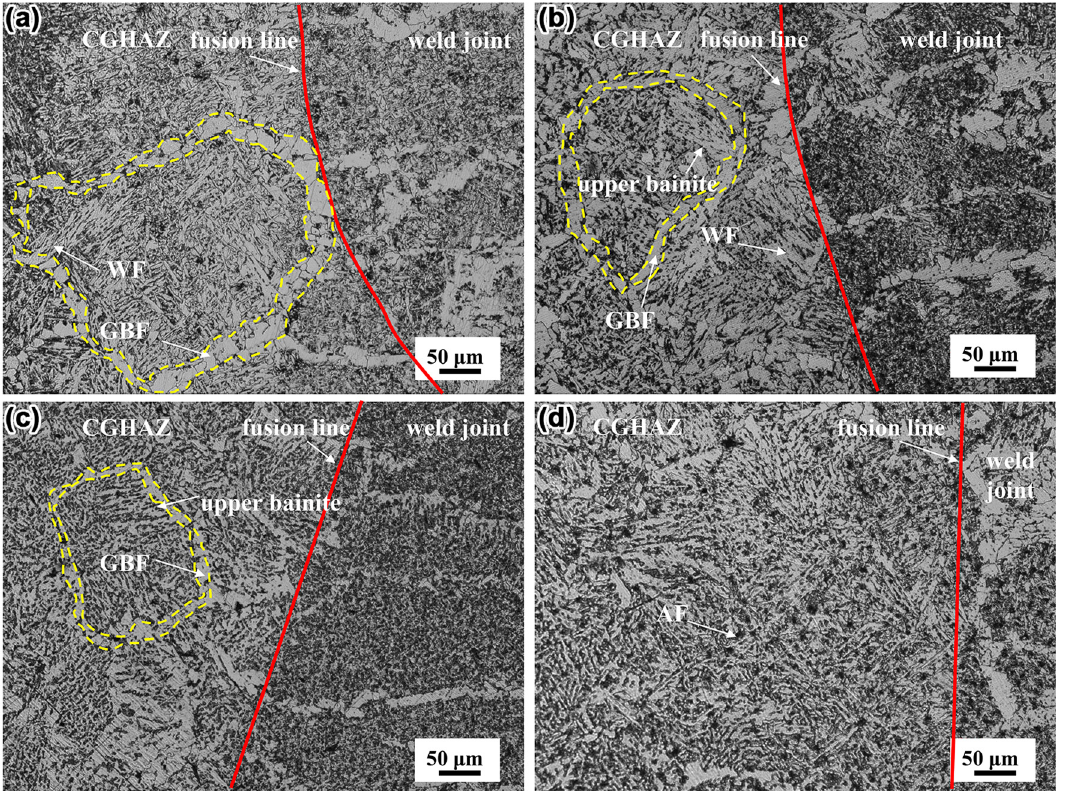
Figure 6. The microstructure of coarse-grained heat-affected zone (CGHAZ) in steels, ( a ) N1 steel, ( b ) N2 steel, ( c ) N3 steel, and ( d ) N4 steel.